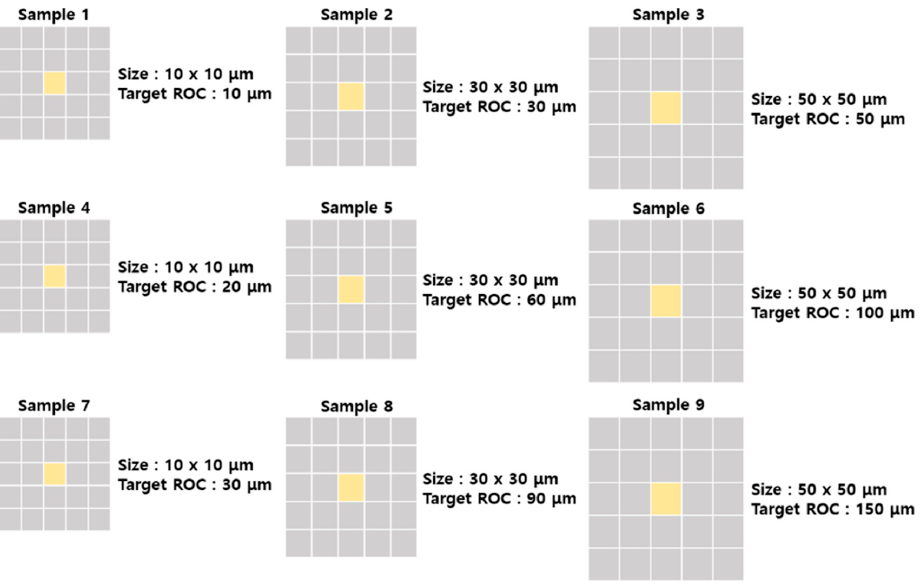
Figure 1. Schematic of master mold for experiments .